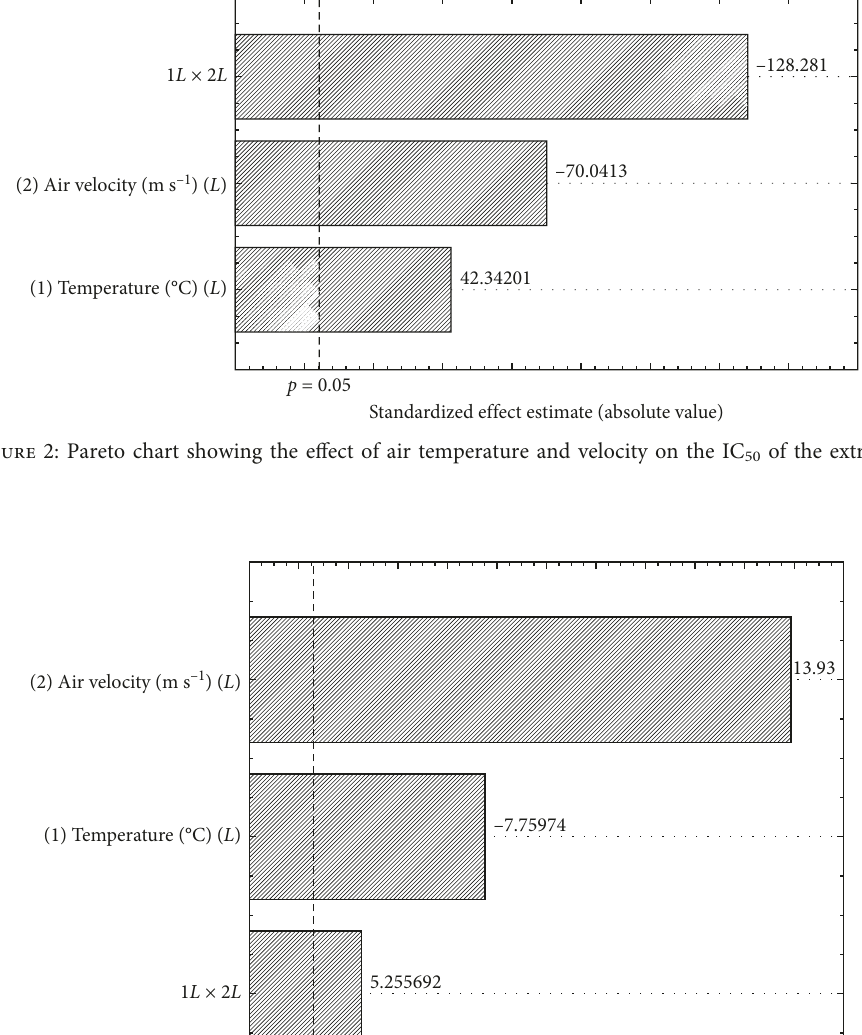
Figure 3: Pareto chart showing the effect of air temperature and velocity on the antioxidant activity of the